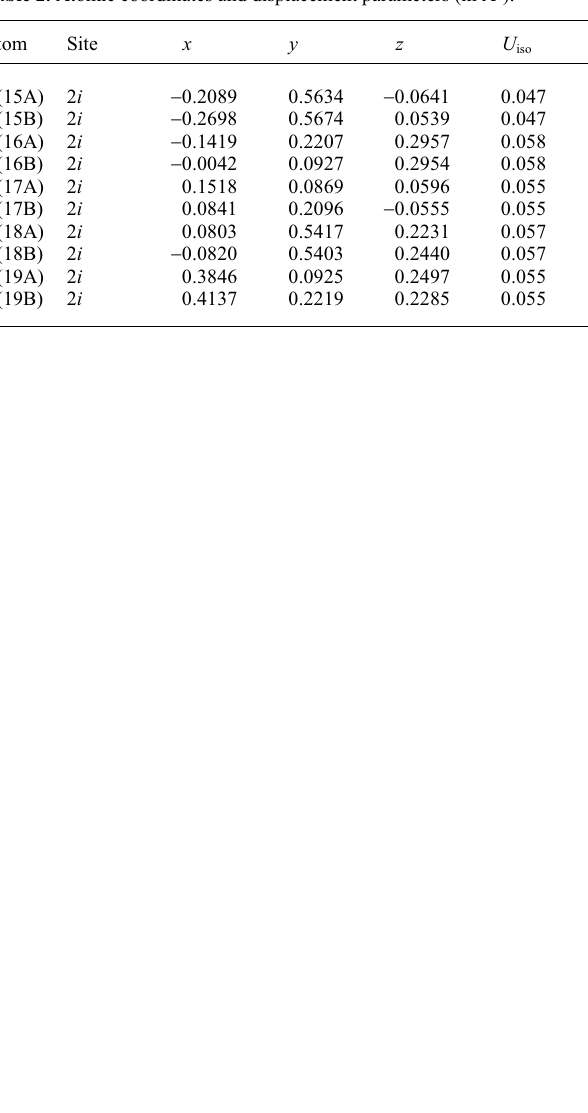
Table 2. Atomic coordinates and displacement parameters (in Å 2 )